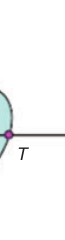
- σ domain for 1 2